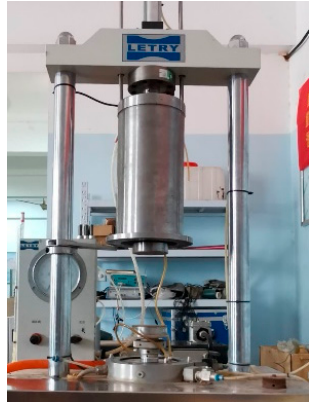
Figure 2. The STD-50 triaxial testing apparatus.